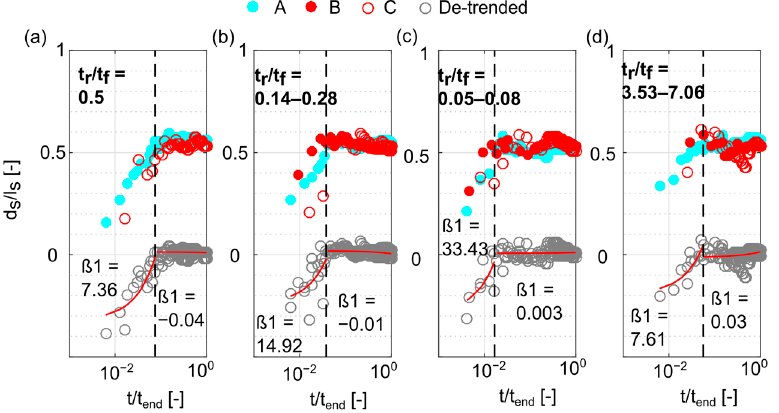
Figure 17. Geometrical relationship of d s /l s vs. nondimensional time in clear-water conditions and for different hydrograph shapes: ( a ) symmetrical, ( b ) positively skewed, ( c ) flash flood, and ( d ) negatively skewed.